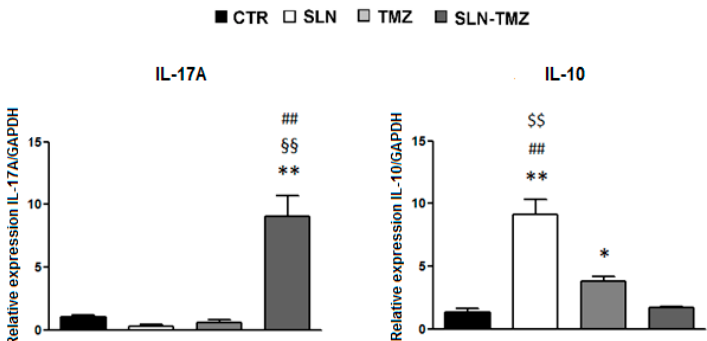
IL-17A and IL-10 expression was evaluated in the tumor mass by Real Time PCR analysis. Data are expressed as mean ± SEM of fold increase versus GAPDH expression ( n = 5). Statistical analyses were performed using one-way ANOVA and the Dunnett test. * p < 0.05; ** p < 0.01 compared to